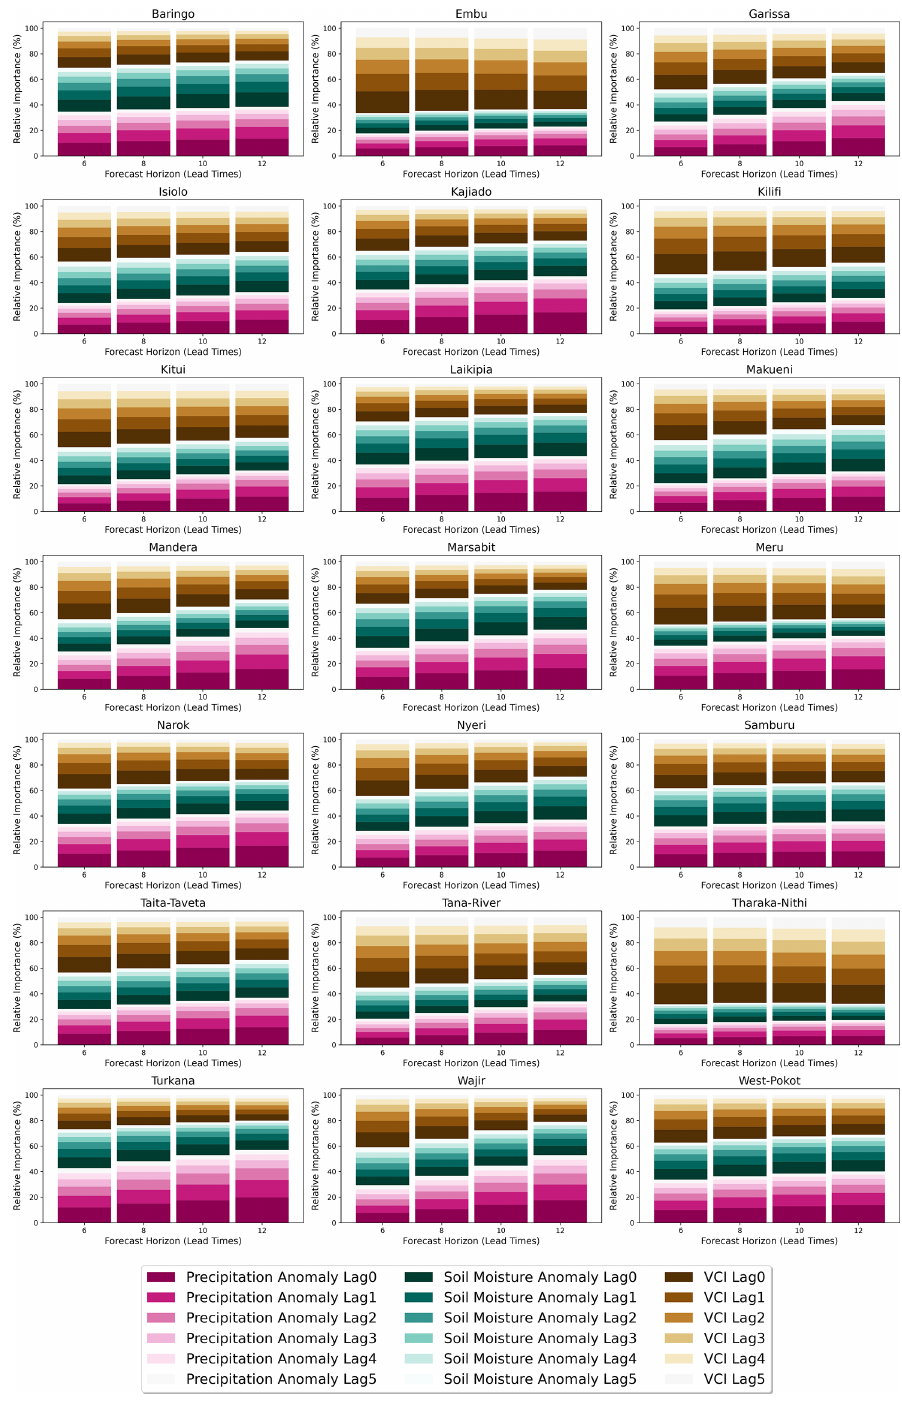
Figure B1. Relative importance for each exogenous factor for each lag (0–5) variable per county. The distinct colour bands show the overall contribution of each input variable, while the varying shades within each band show the individual contribution of each lagged input variable of precipitation, soil moisture, and